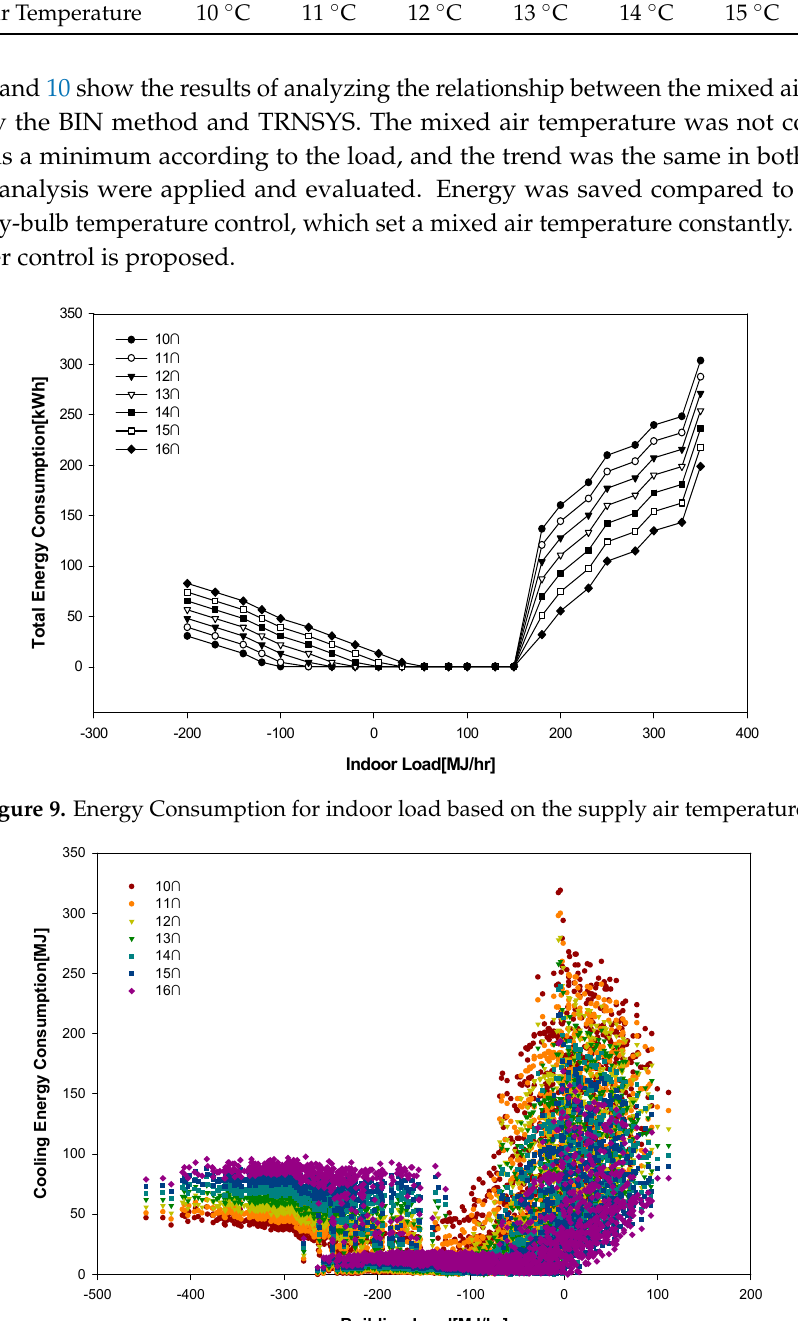
Figure 10. Cooling energy consumption for the indoor load.